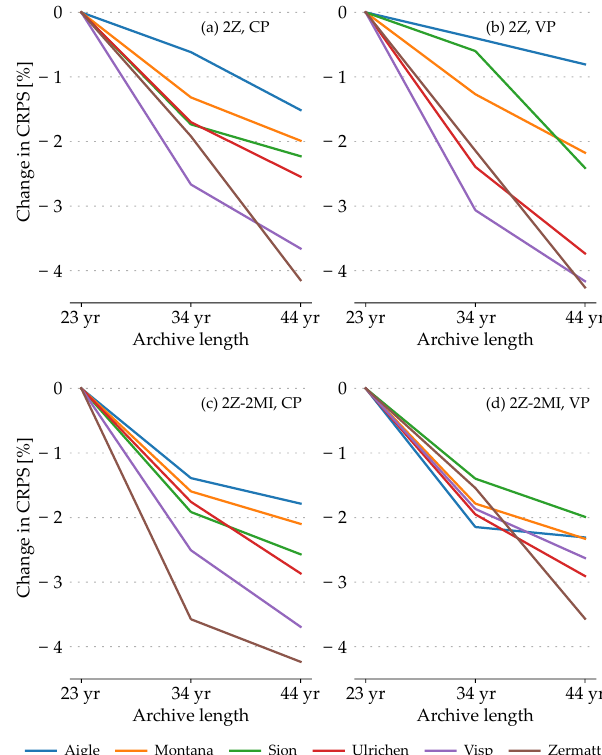
Figure 14. Change in performance score (CRPS) of the 2Z (top) and 2Z-2MI (bottom) methods at the different stations for the CP (left) and VP (right) for an increasing archive length with the conven- tional approach of 24h window. Lower CRPS scores indicate better